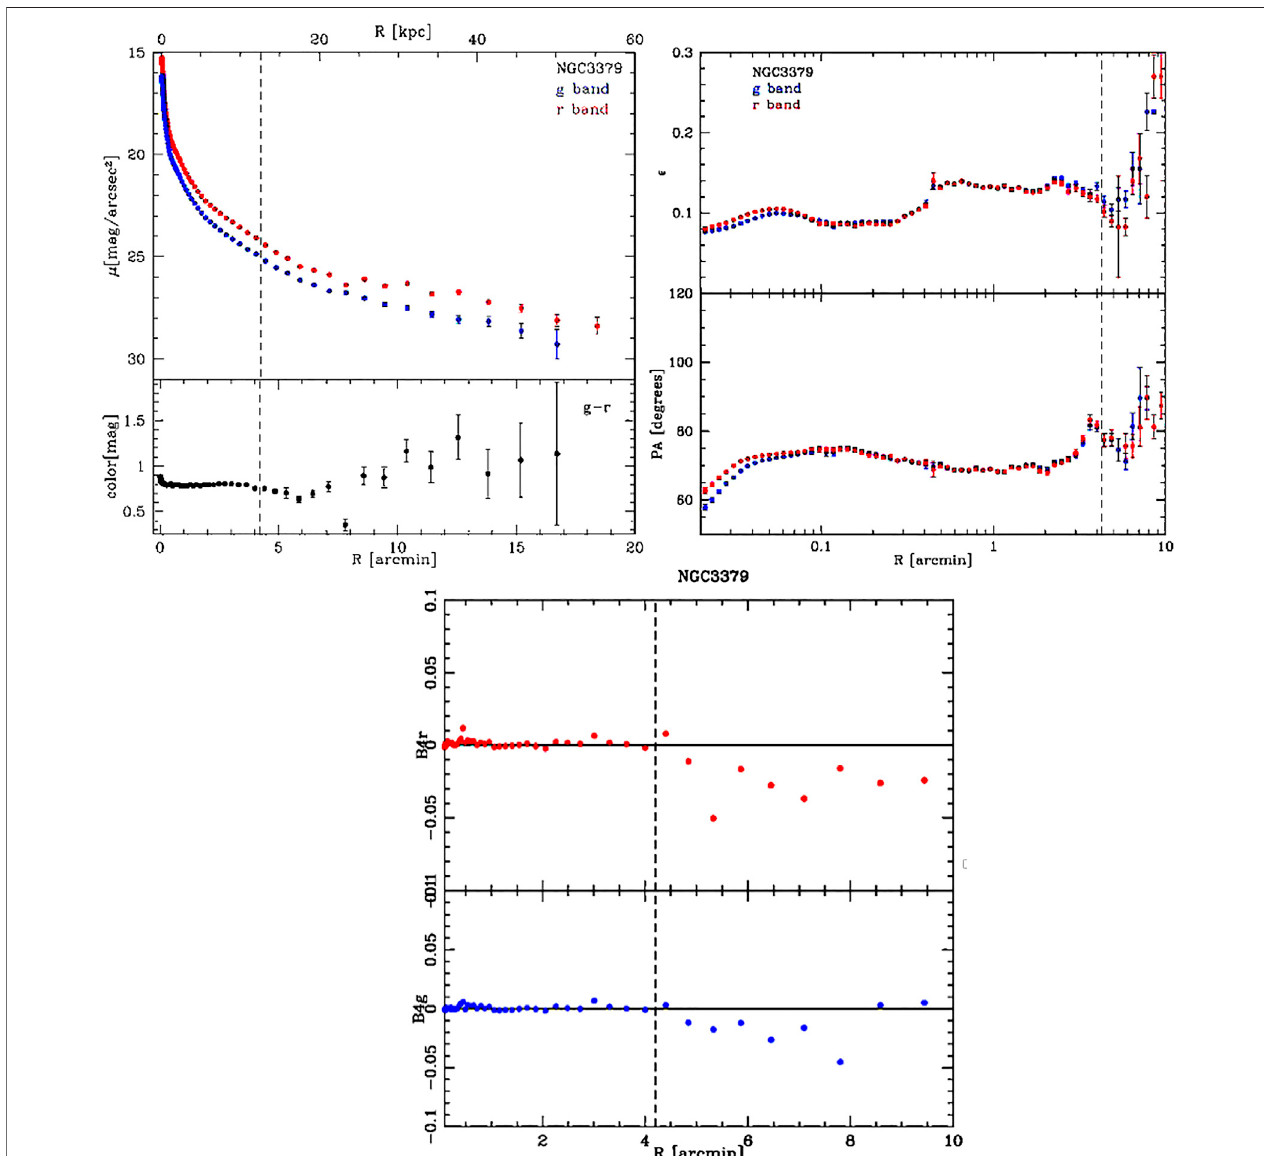
FIGURE3| Topleftpanels: azimuthally-averagedsurfacebrightnesspro fi lesofNGC3379inVST g (blue)and r (red)bands(toppanel)and g − r colorpro fi leofNGC 3379(bottom panel). Toprightpanel: azimuthally-averagedellipticity(toppanel)andpositionangle(bottompanel)pro fi lesofNGC3379inVST g (blue)and r (red)bands. TheblackdashedlinescorrespondtotheR tr (seeSection3.4). Bottompanels: radialpro fi lestheB4Fouriercoef fi cientasafunctionofsemi-majoraxisinVST r (toppanel) and g (bottom panel) bands for NGC 3379. The vertical dashed line corresponds to R tr , beyond which the isophotes show a boxy shape (see details in the text in Section.